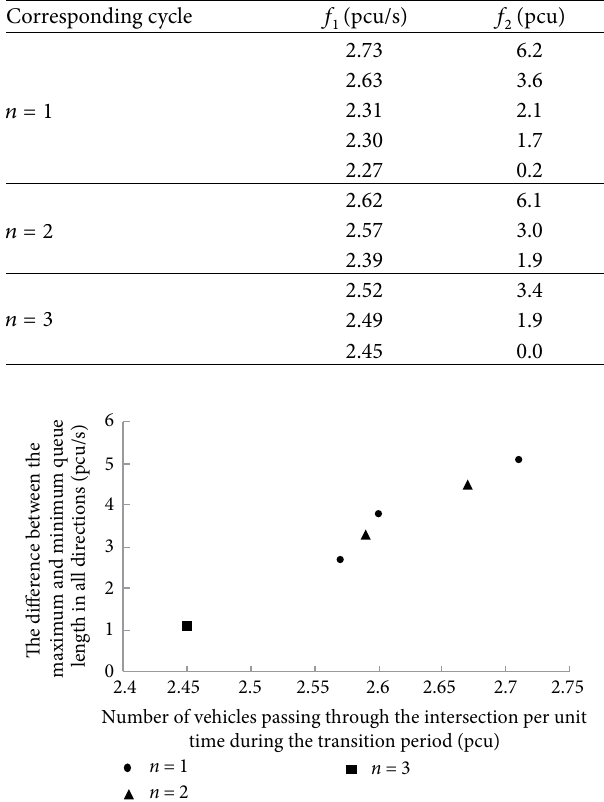
is 10 o’clock. 0